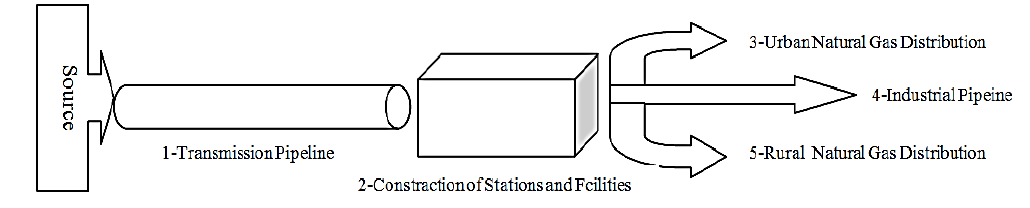
Fig. 1. Types of natural gas distribution